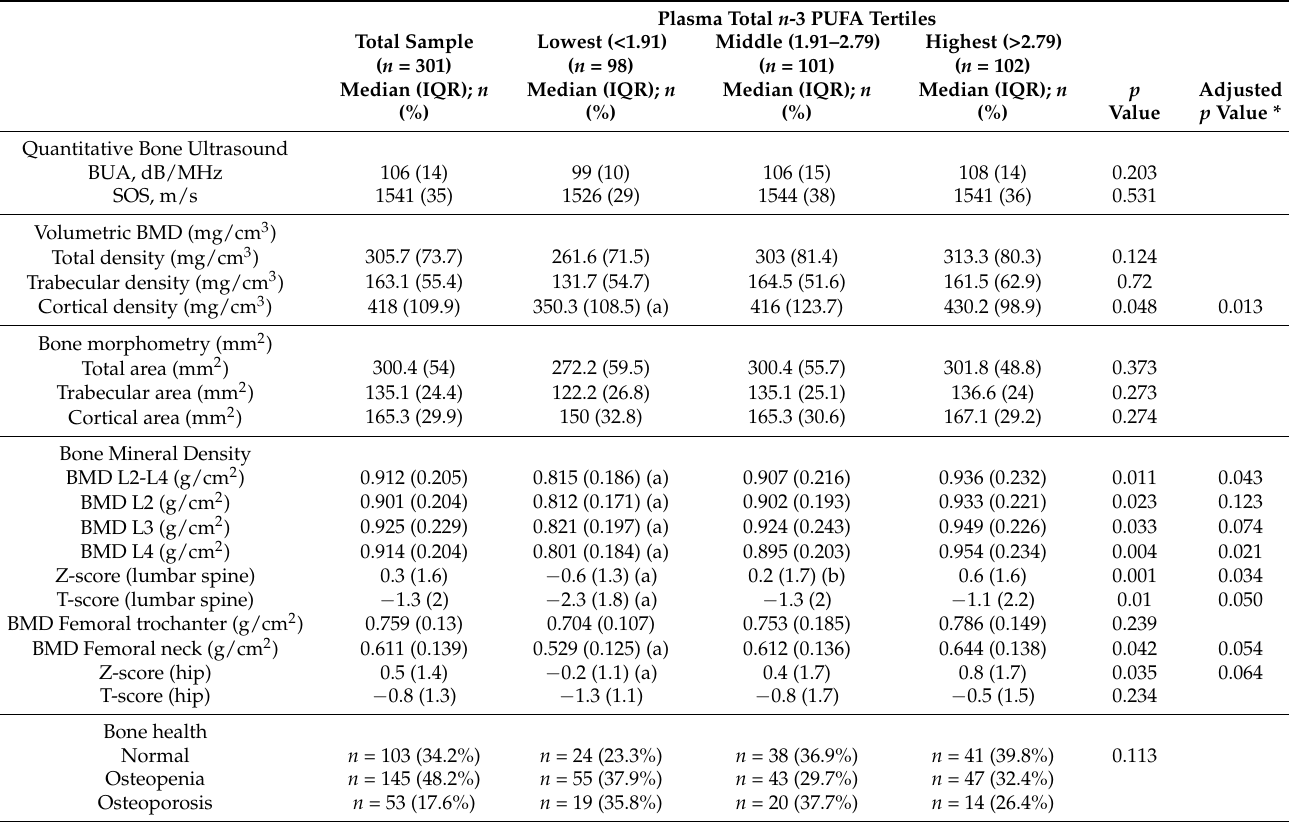
Table 3. Bone parameters by tertile of plasma n -3 PUFA (C18:3 (n3) Linolenic acid (ALA) + C20:5 (n3) Eicosapentenoic